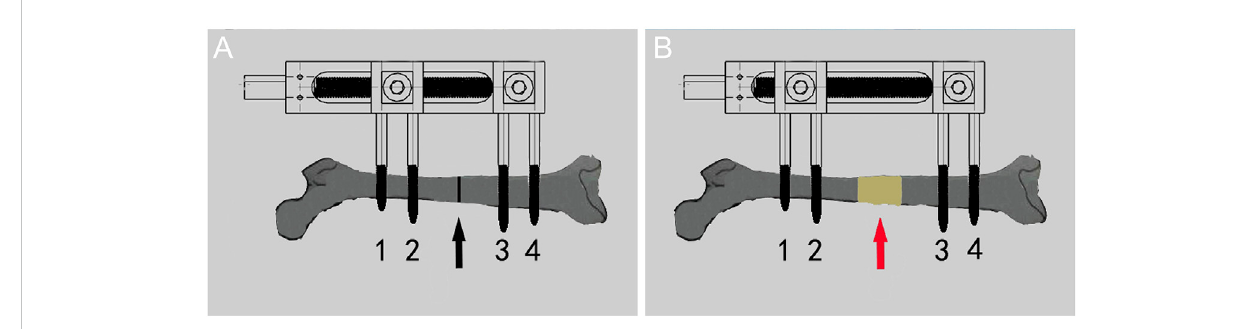
FIGURE 3 Diagram of theprocess ofdistraction osteogenesisinrats. (A) Before distraction thefemur (black arrowshows osteotomy area). (B) After distraction the femur (red arrow shows the distraction area).